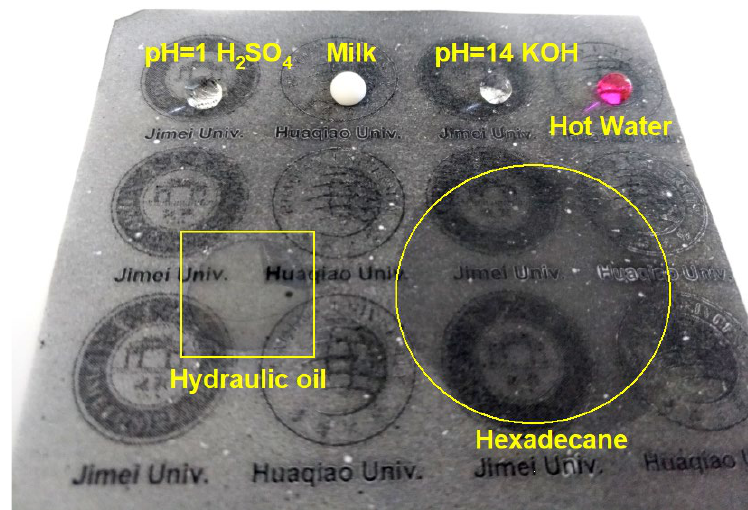
Figure 4. Super big droplets (c.a. 0.15 mL) of various liquids on the printing paper that is coated with electrosprayed PVDF/CS composites. Details are indicated in the figure, where the temperature for the hot water is about 85 °C.